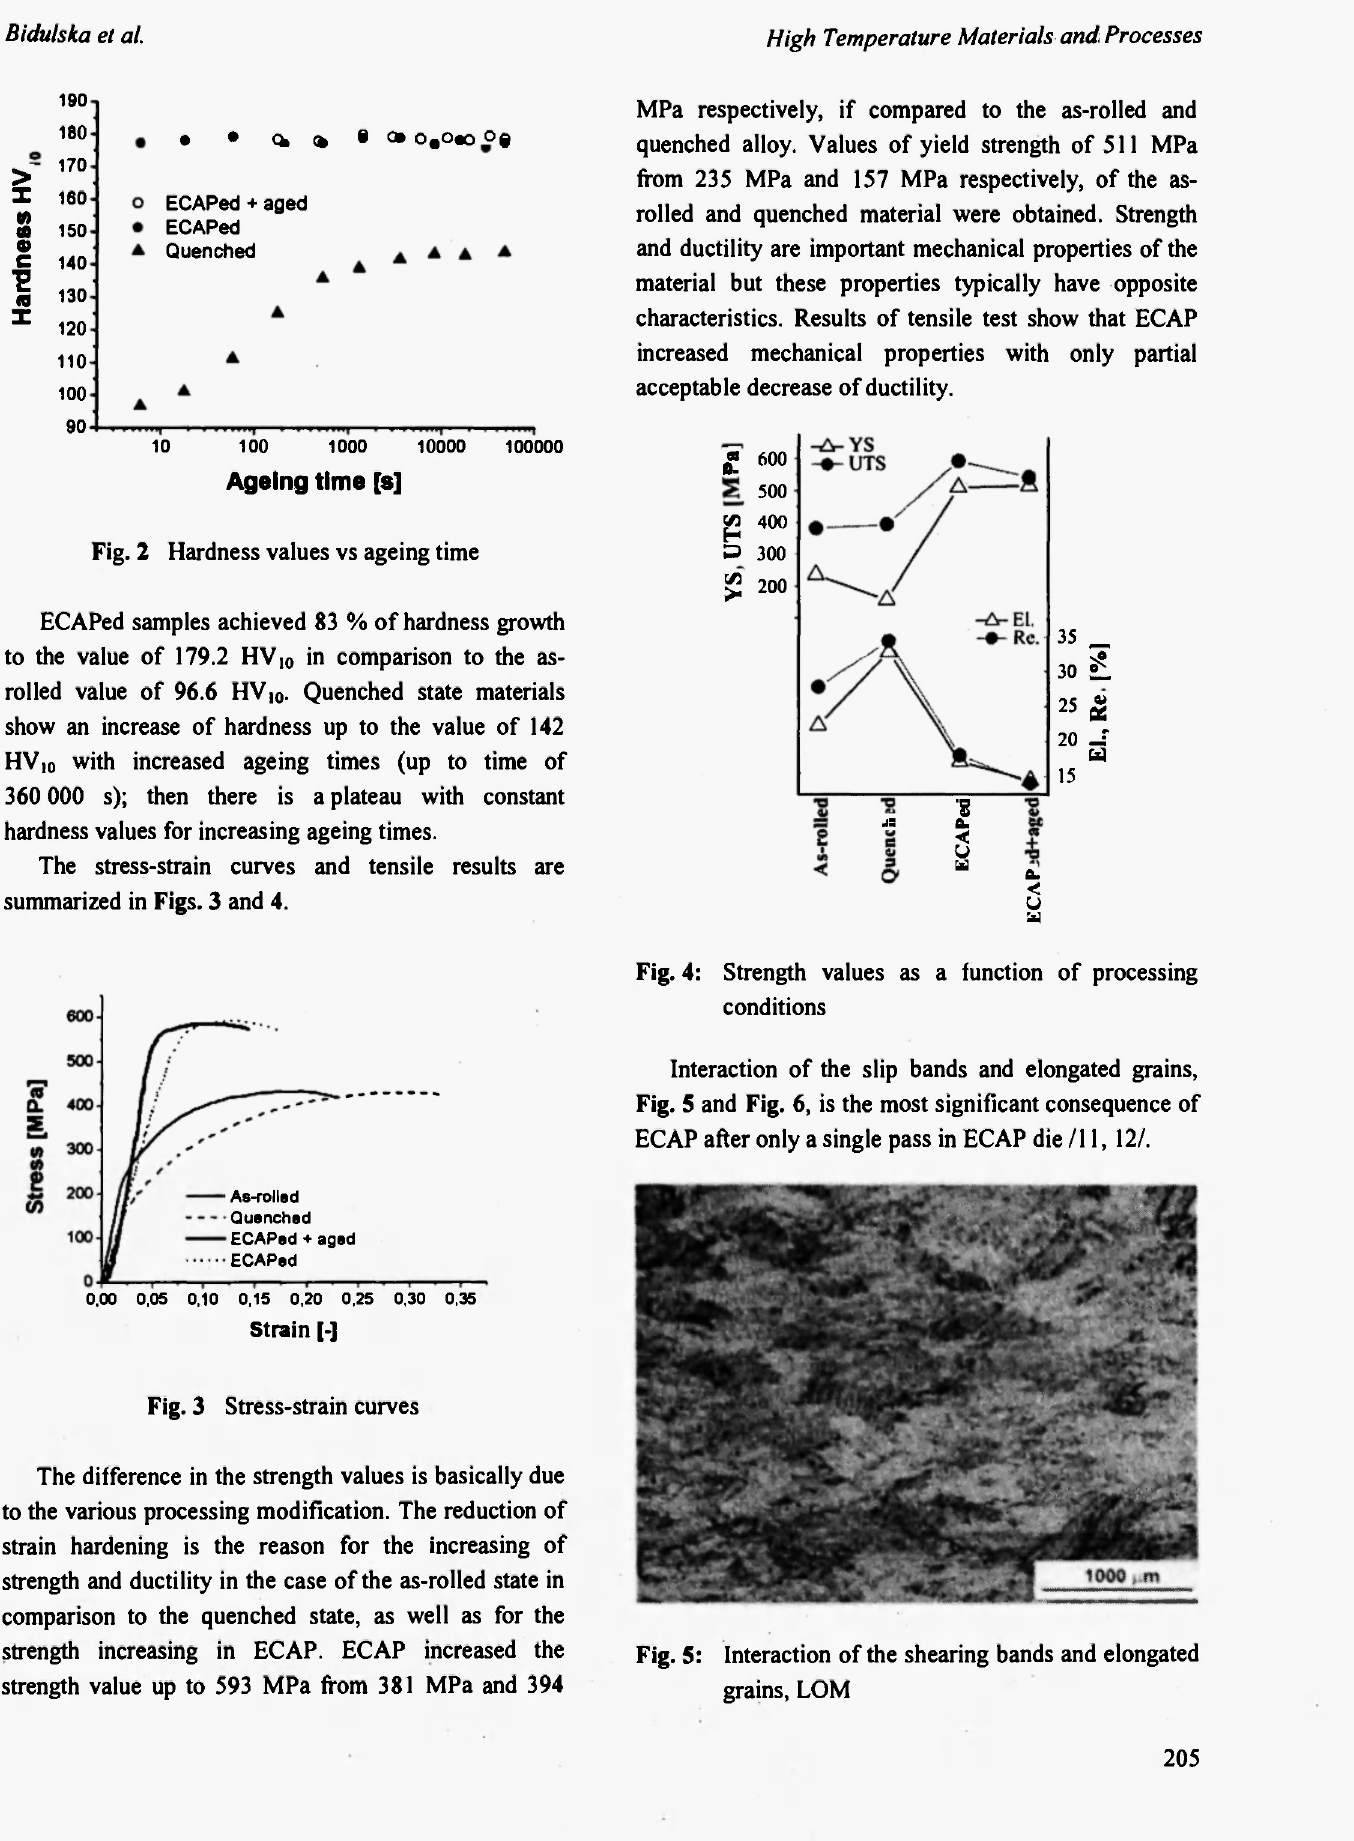
Fig. 3 Stress-strain curves